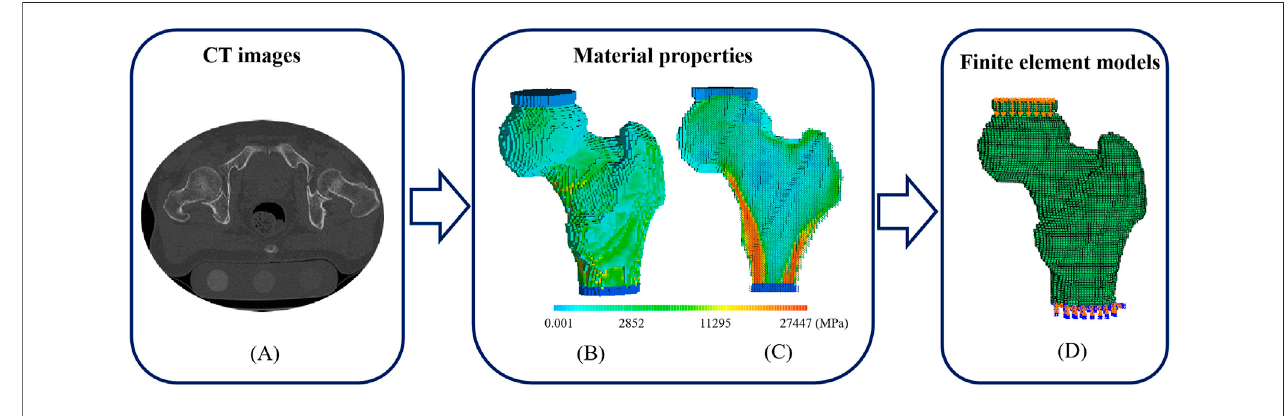
FIGURE1| AtypicalCTimage,distributionsofelasticmodulusandthecorrespondingFEmodelwithloadsandboundaryconditions. (A) AtransverseCTimageof aproximalfemur (B) Elasticmodulusdistribution ofaproximalfemur (C) Elasticmodulusdistribution ofaproximalfemurincross-section (D) FEmodelwithcompressive deformation on the top surface of polymethylmethacrylate (PMMA) pad for femoral head and fi xed bottom surface of PMMA pad for distal